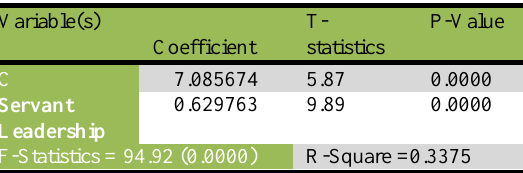
Table 4: Summary of Hypothesis 2 Result